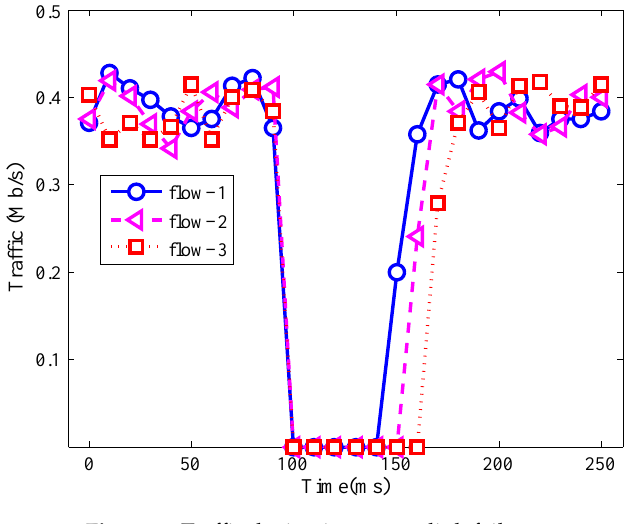
Figure 5. Traffic during intra-topo link failure.